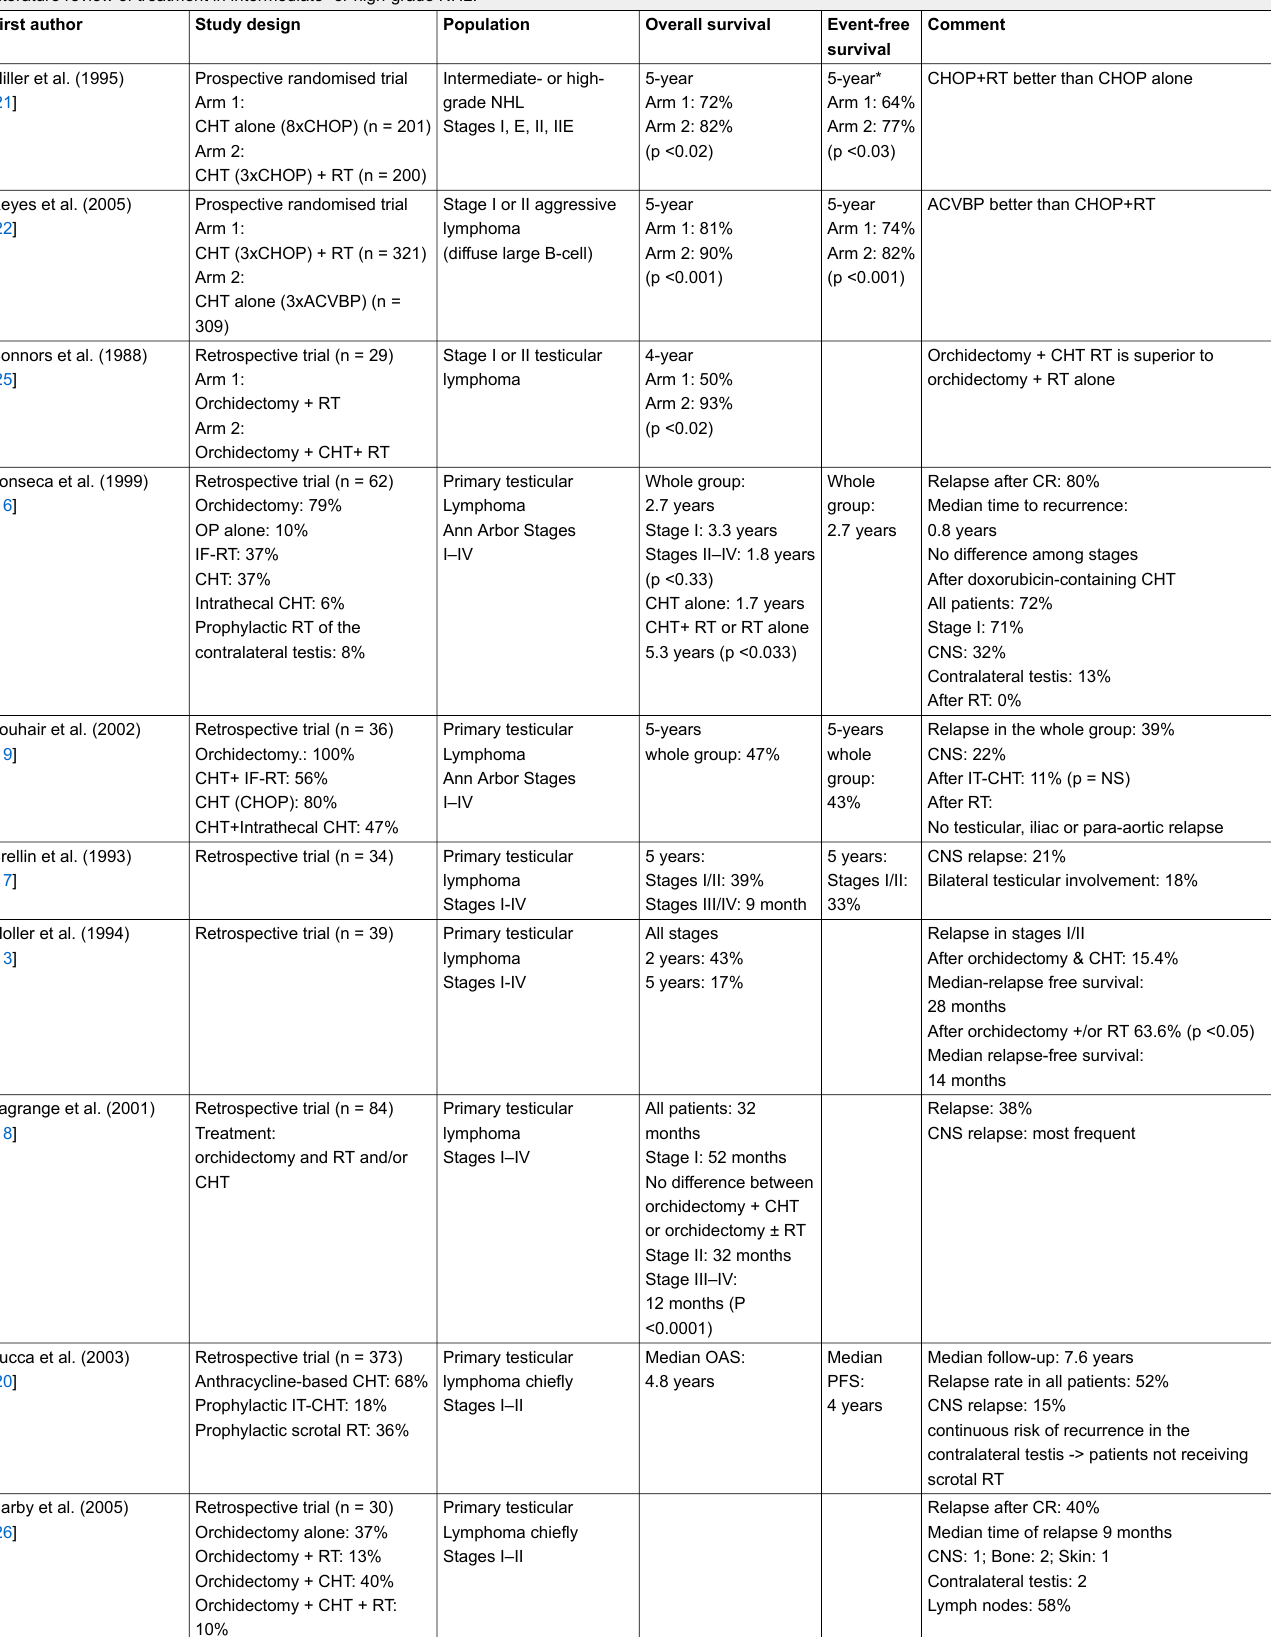
Table 1 Literature review of treatment in intermediate- or high-grade